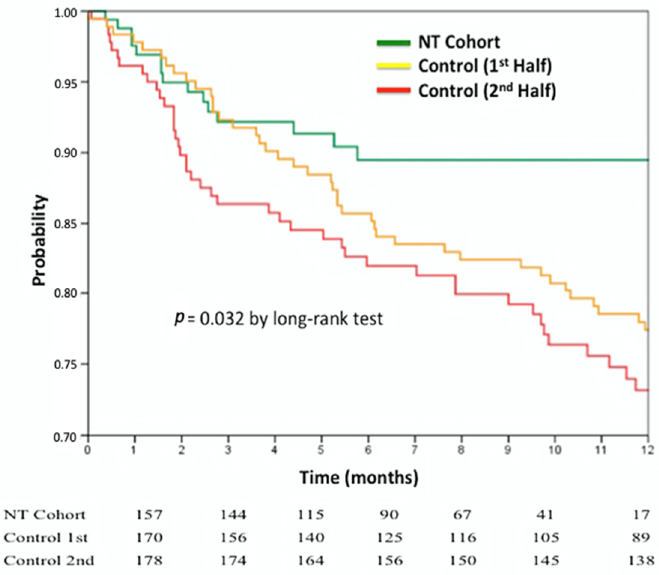
Figure 1. Freedom from death, surgery, and CHF admission.